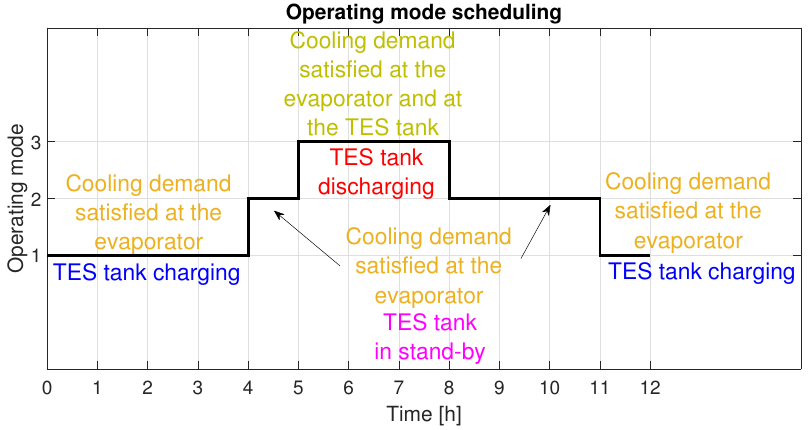
Figure 11. Proposed operating mode